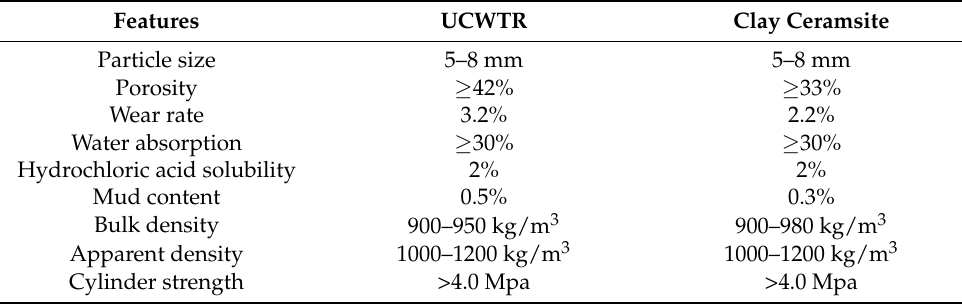
Table 2. Characteristic parameters of UCWTR and clay ceramsite.